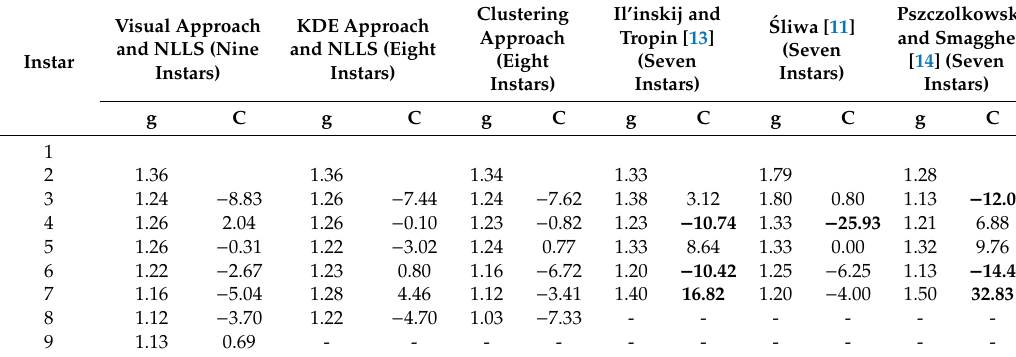
Table 3. Brooks-Dyar’s ratios (g) and Crosby’s growth ratios (C) for head capsule widths of Dendrolimus pini larvae at di ff erent instars separated using three approaches tested in our study compared to those presented by other studies (the bold values indicate C > | 10 | , indicating significant deviation from Brooks-Dyar’s